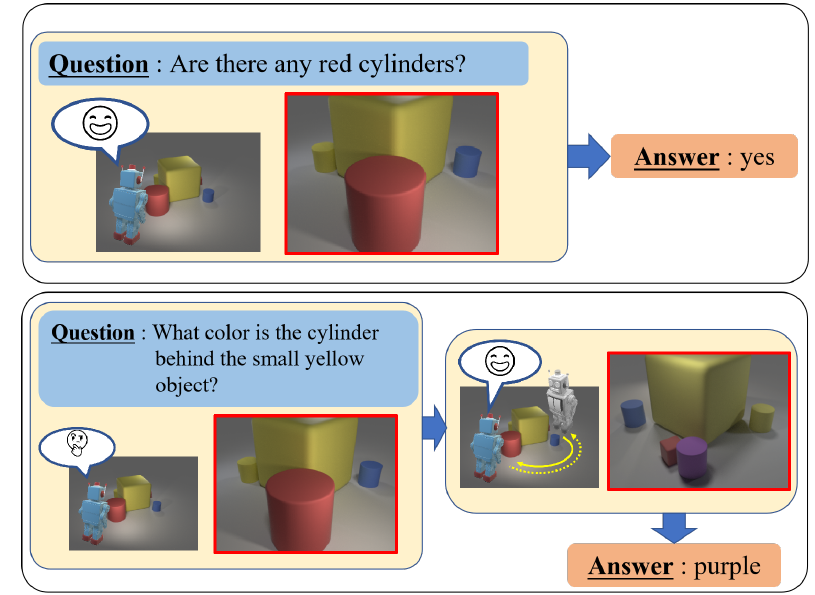
Figure 1. Illustration of multi-view VQA with active viewpoint selection. Our framework selects the observation viewpoint (highlighted in red bounding boxes) to answer questions based on the observed scene